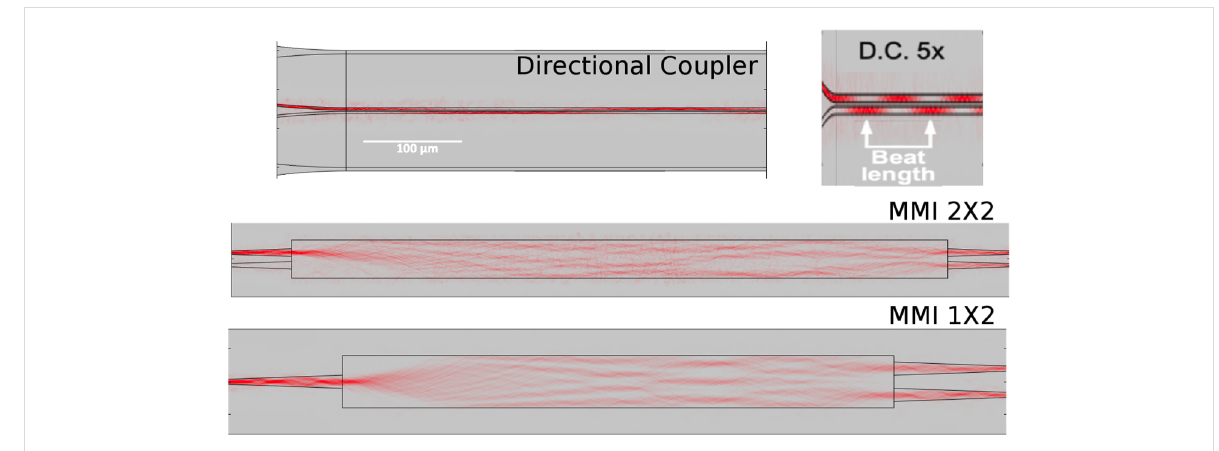
Figure 1: COMSOL simulations of light propagation in a directional coupler and two MMIs, all having rectangular cross sections. The red dots show the distribution of power density. The inset at the top right is the same sketch of the directional coupler, squeezed 5× horizontally and stretched 5× vertically to emphasize the power transfer and beat